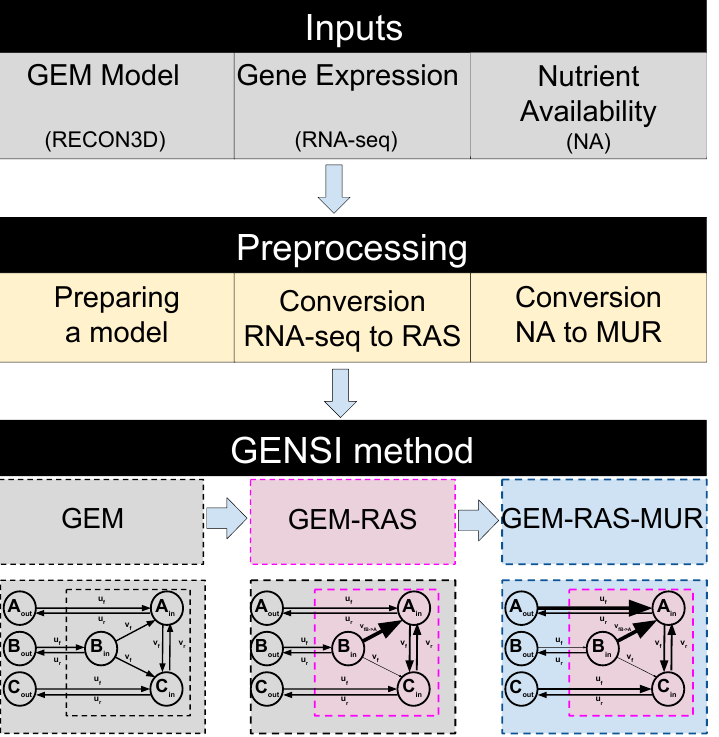
Figure 1. The Gene Expression and Nutrients Simultaneous Integration (GENSI) workflow requires three inputs: a Genome-Scale Model (GEM) model, gene-expression, and nutrient availability data (first block). In the pre-processing step (second block), the RNA-seq is converted into RAS [30] that is defined for any reaction r associated with gene(s) in the GEM and describes the extent of its activity, as a function of the expression of the genes encoding for the subunits and/or the isoforms of the associated enzyme(s). The Nutrient Availability (NA) data is converted to a Maximal Uptake Rate (MUR) that is defined for any exchange reaction r ex in the GEM and describes the rate of the maximum possible uptake over time for substances available for the model (nutrients). Substances available for uptake are limited by the composition of the medium. Finally, GENSI (third block) integrates GEM, RAS, and